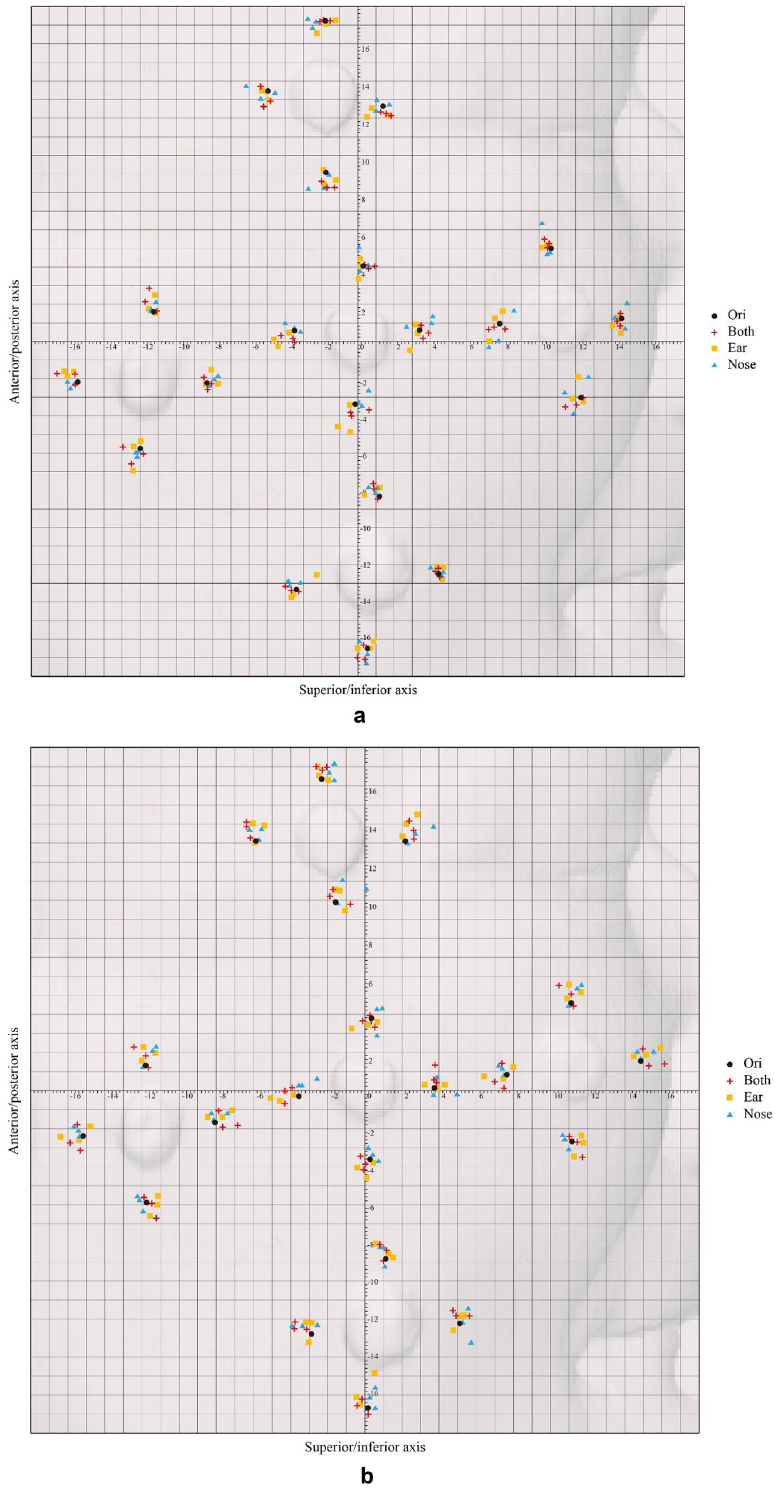
Figure 4. A graphic representation of the planned point and an actual point placement on the skin surface. ( a ) Placement of the entry point. ( b ) Placement of the